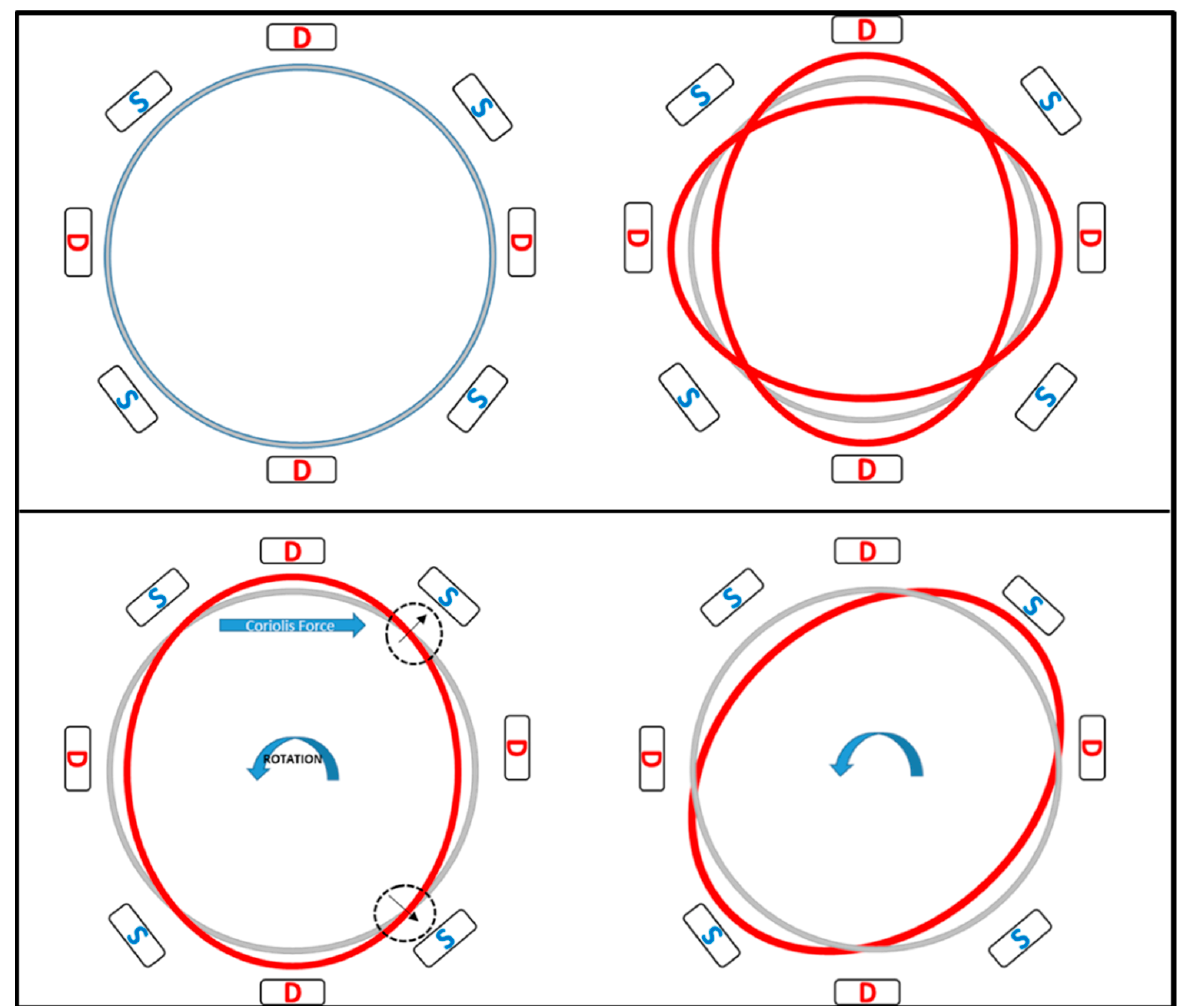
Figure 14. Schematic demonstration of the operation of a vibrating ring gyroscope.